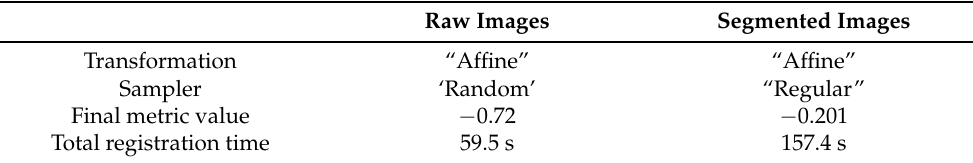
Table 7. Result of 3D affine registration using SimpleITK.